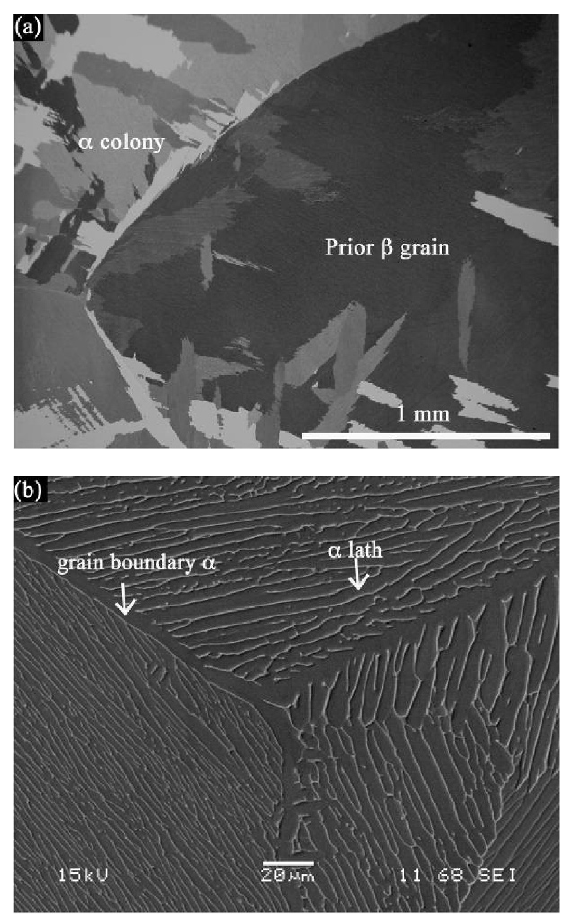
Figure 2. (a) Optical micrograph of cast Ti-64 showing part of a prior β grain and α colonies. (b) Secondary electron micrograph of cast Ti-64 showing α laths and grain boundary α